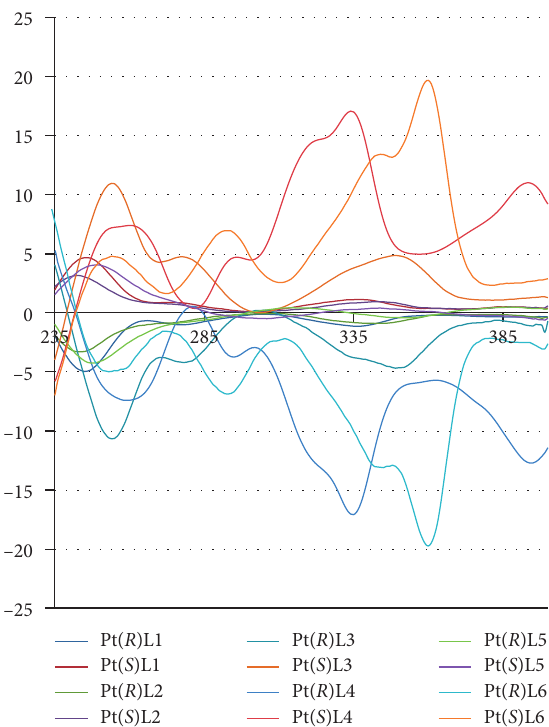
Figure 2: CD spectra of chiral salen Pt(II) complexes.